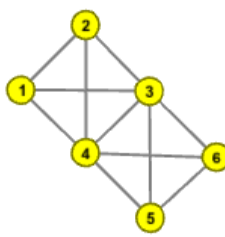
Figure 3. Example of complete subgraph folding.